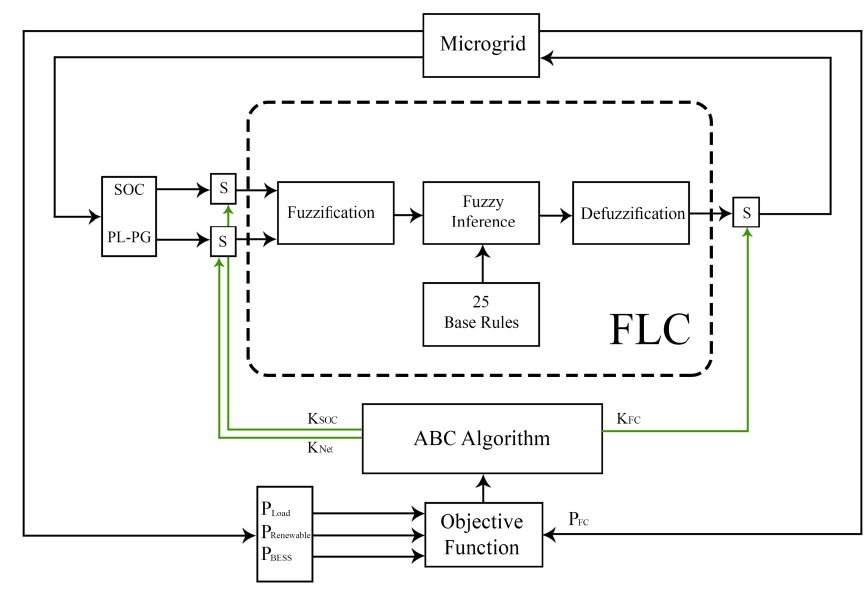
Figure 6. Optimization model of the fuzzy logic controller using the ABC algorithm.